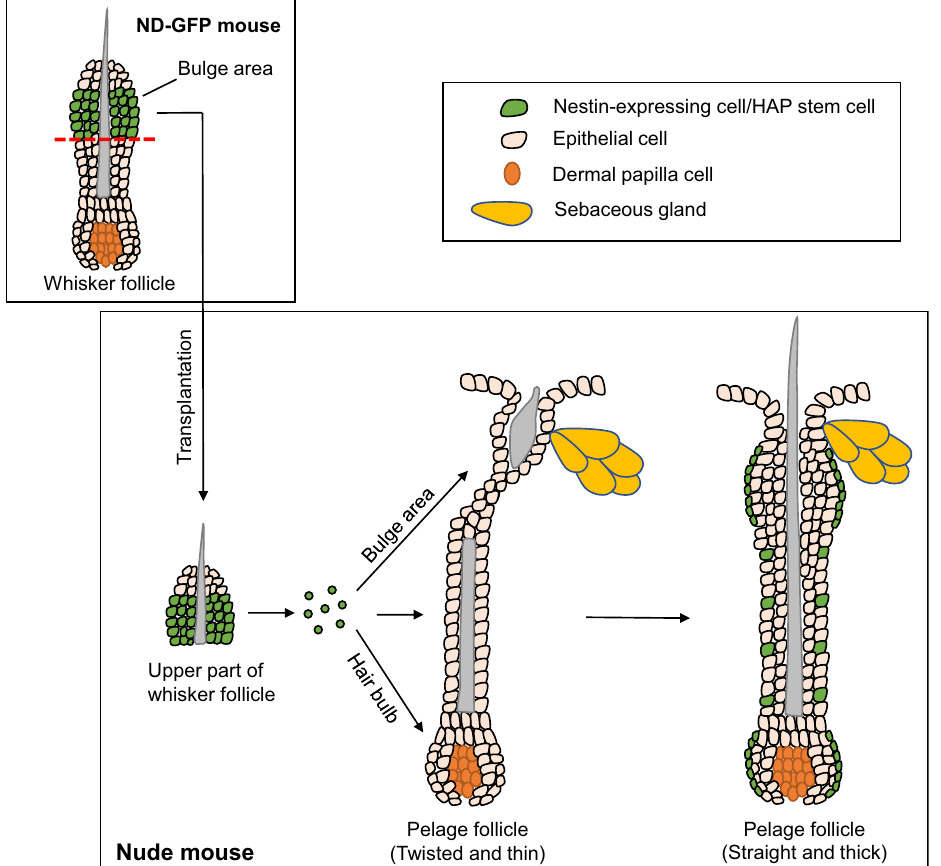
Figure 7. Illustration of hair-growth stimulation of nude mice after transplantation of HAP stem cells. When the upper part of whisker follicles of ND-GFP mice was transplanted to nude mice, HAP stem cells expressing GFP jumped and targeted nude-mouse pelage follicles, mainly in the bulge and hair bulb where they differentiated to keratinocytes. As a result, pelage follicles of nude mice become wider and the twisted infundibulum was straightened, and extensive and long-term hair growth of nude mice was